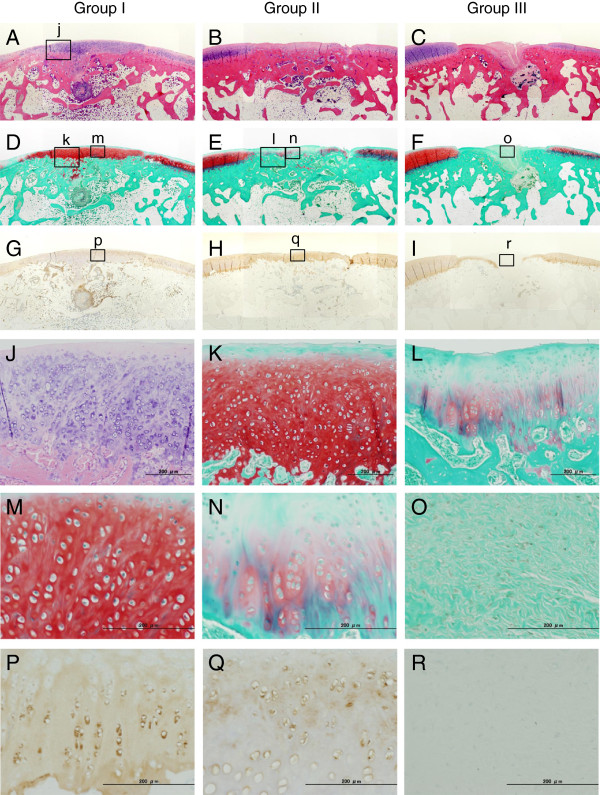
Histological observations of the defect at 12 weeks (A-C: Hematoxylin-Eosin staining, D-F: Safranin-O staining, G-I: immuno-histological staining for type II collagen, original magnification ×2). Group I was filled with a proteoglycan-rich tissue, in which type 2 collagen was abundantly expressed (A, D, and G). In high magnification histology of Group I, no cleft was observed between the regenerated tissue and the normal cartilage tissue (j: A black bar shows 200 micrometer). In the regenerated tissue, fairly large round cells rich in cytoplasm were scattered singly or as an isogenous group in a proteoglycan-rich matrix (k, l, p). In Group II, the defect was filled with thin heterogeneous tissues, including cartilage, fibrous, and bone tissues at 12 weeks (B and E). In this tissue, type 2 collagen was not uniformly expressed (H, q). In this tissue, cells were rather small and sparse (m, n). In Group III, the defect was filled with the fibrous and bone tissues (Figure C and F), while the type 2 collagen expression was not found in this tissue (I, r).